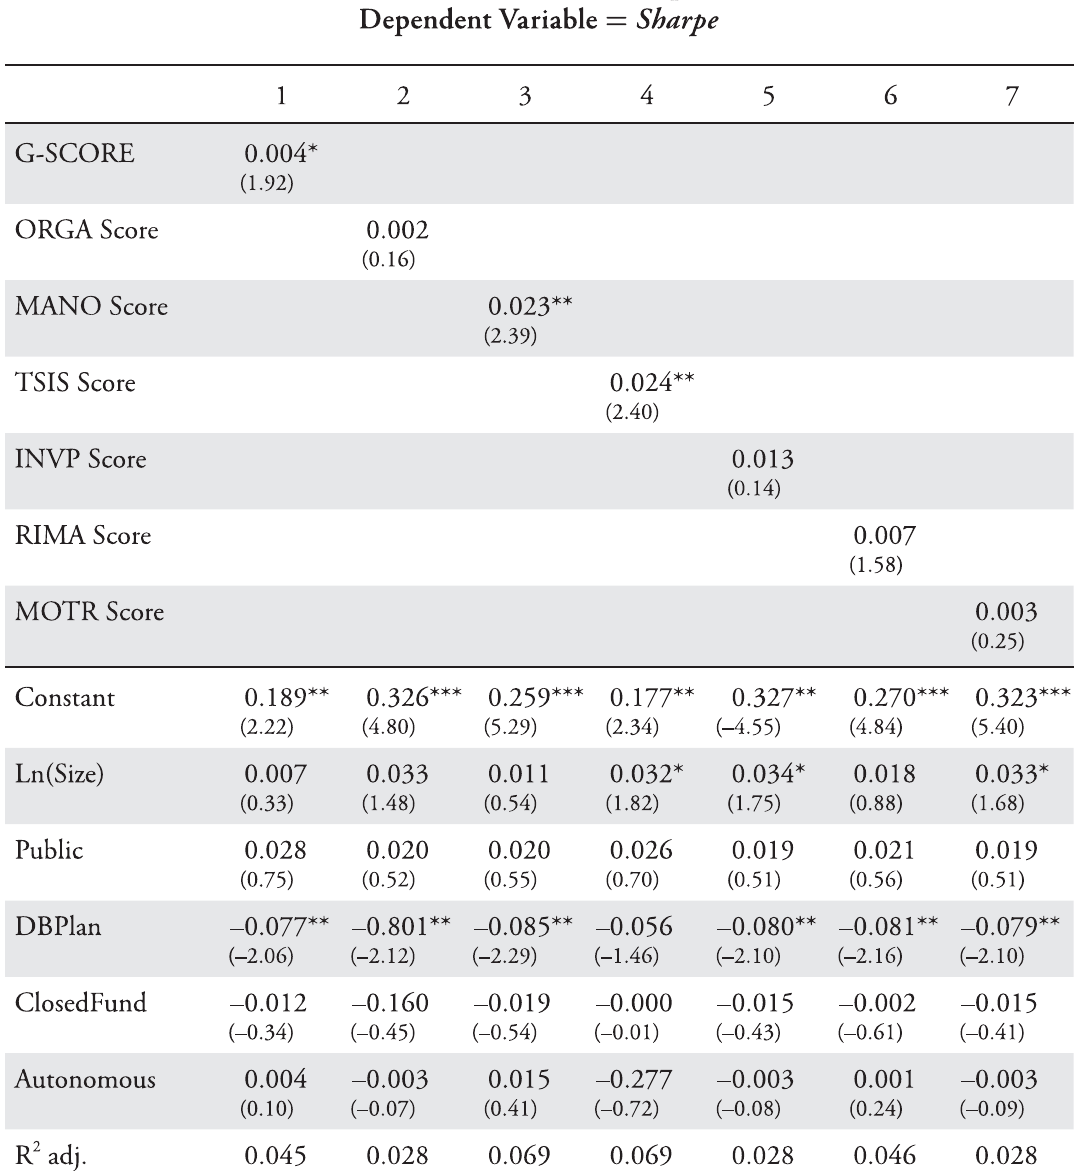
Table 16: Governance and Sharpe